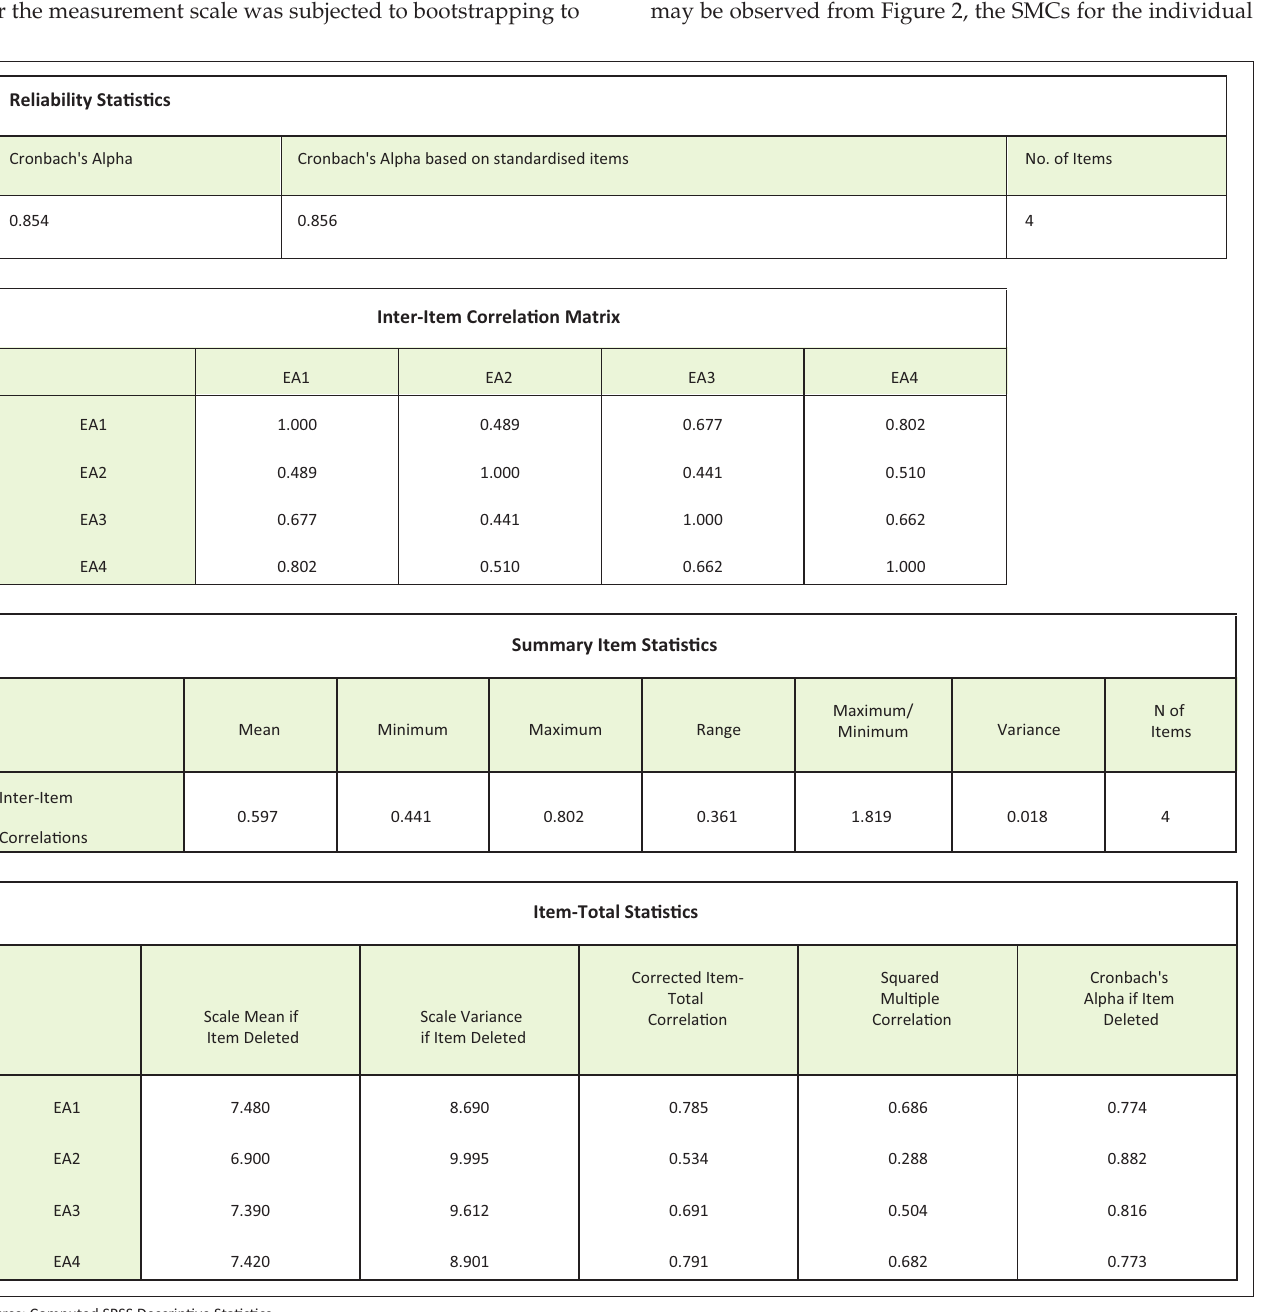
FIGURE 2: Measurement reliability